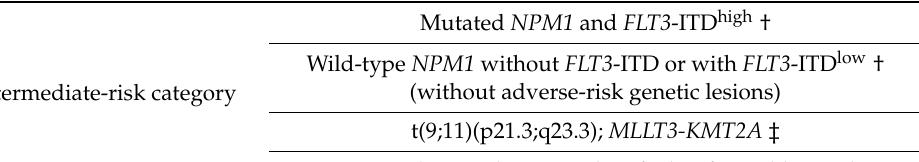
Table 1. 2017 ELN intermediate-risk stratification by genetics. Adapted from